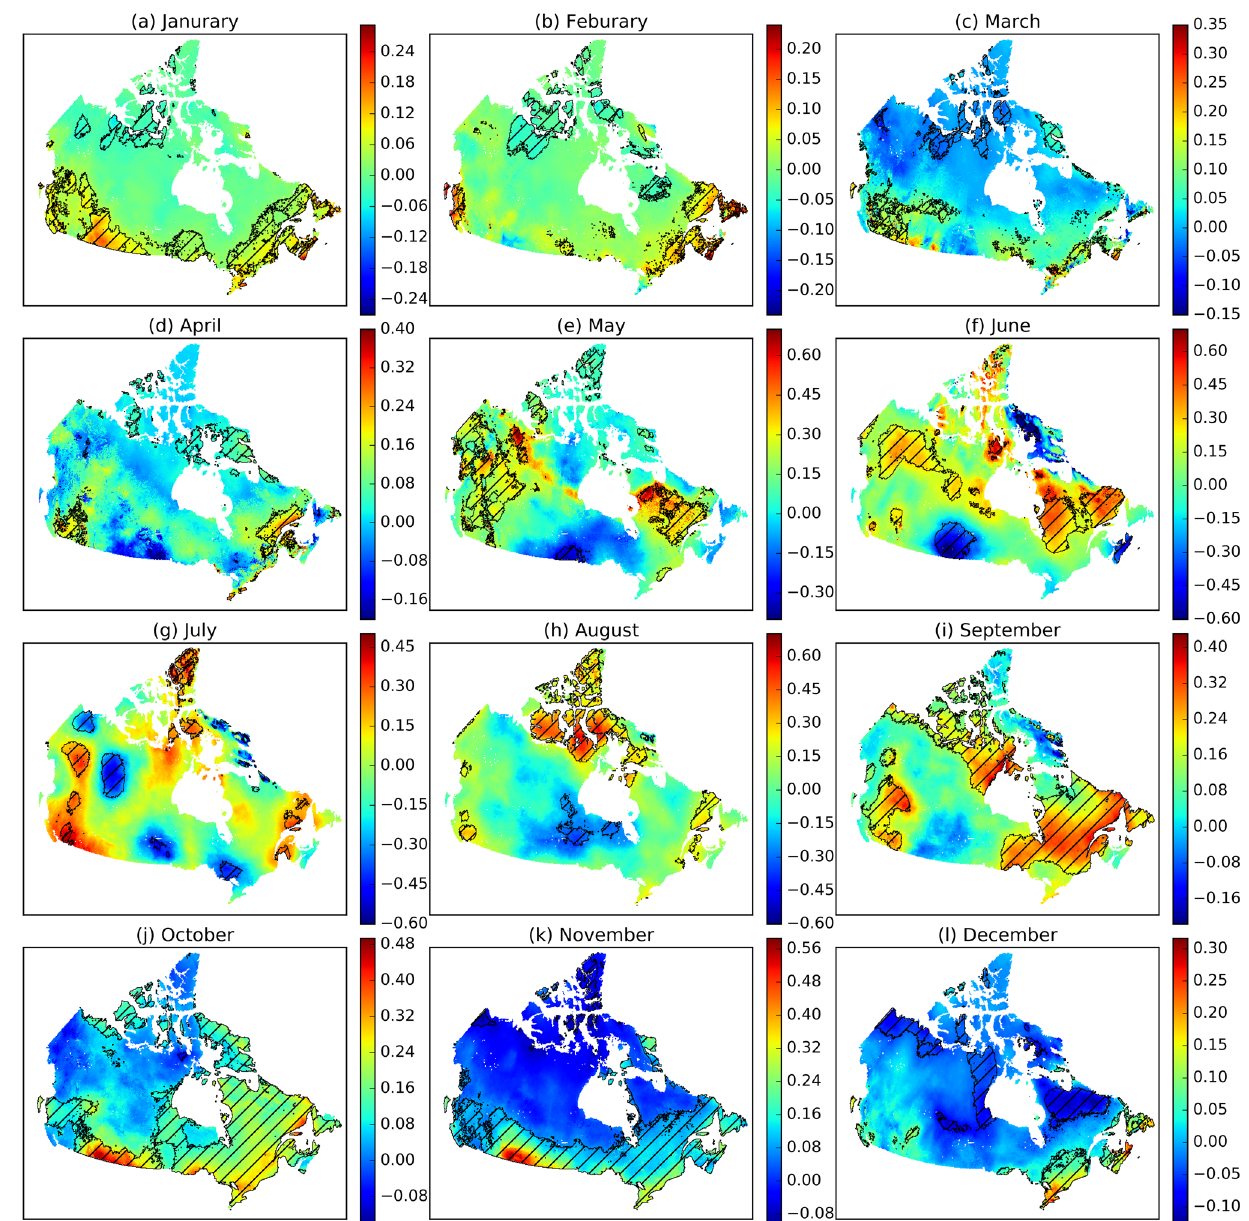
Figure 9. The trends of monthly potential evaporation (PE, mm/month) in 1979–2016 in Canada, indicated by Sen’s slope (Hatching indicates the statistically significant trend at the 95% confidence interval. The map was created using our own script in Anaconda Python 3.8 downloaded from https ://docs.anaco nda.com/anaco nda/ insta